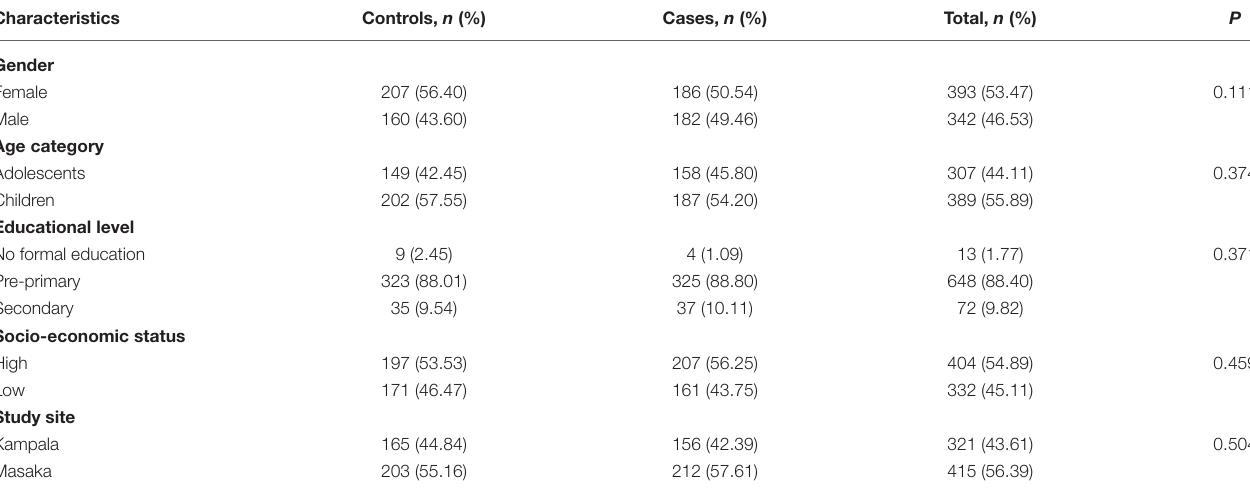
TABLE 1 | Distribution of socio-demographic characteristics between cases and controls.